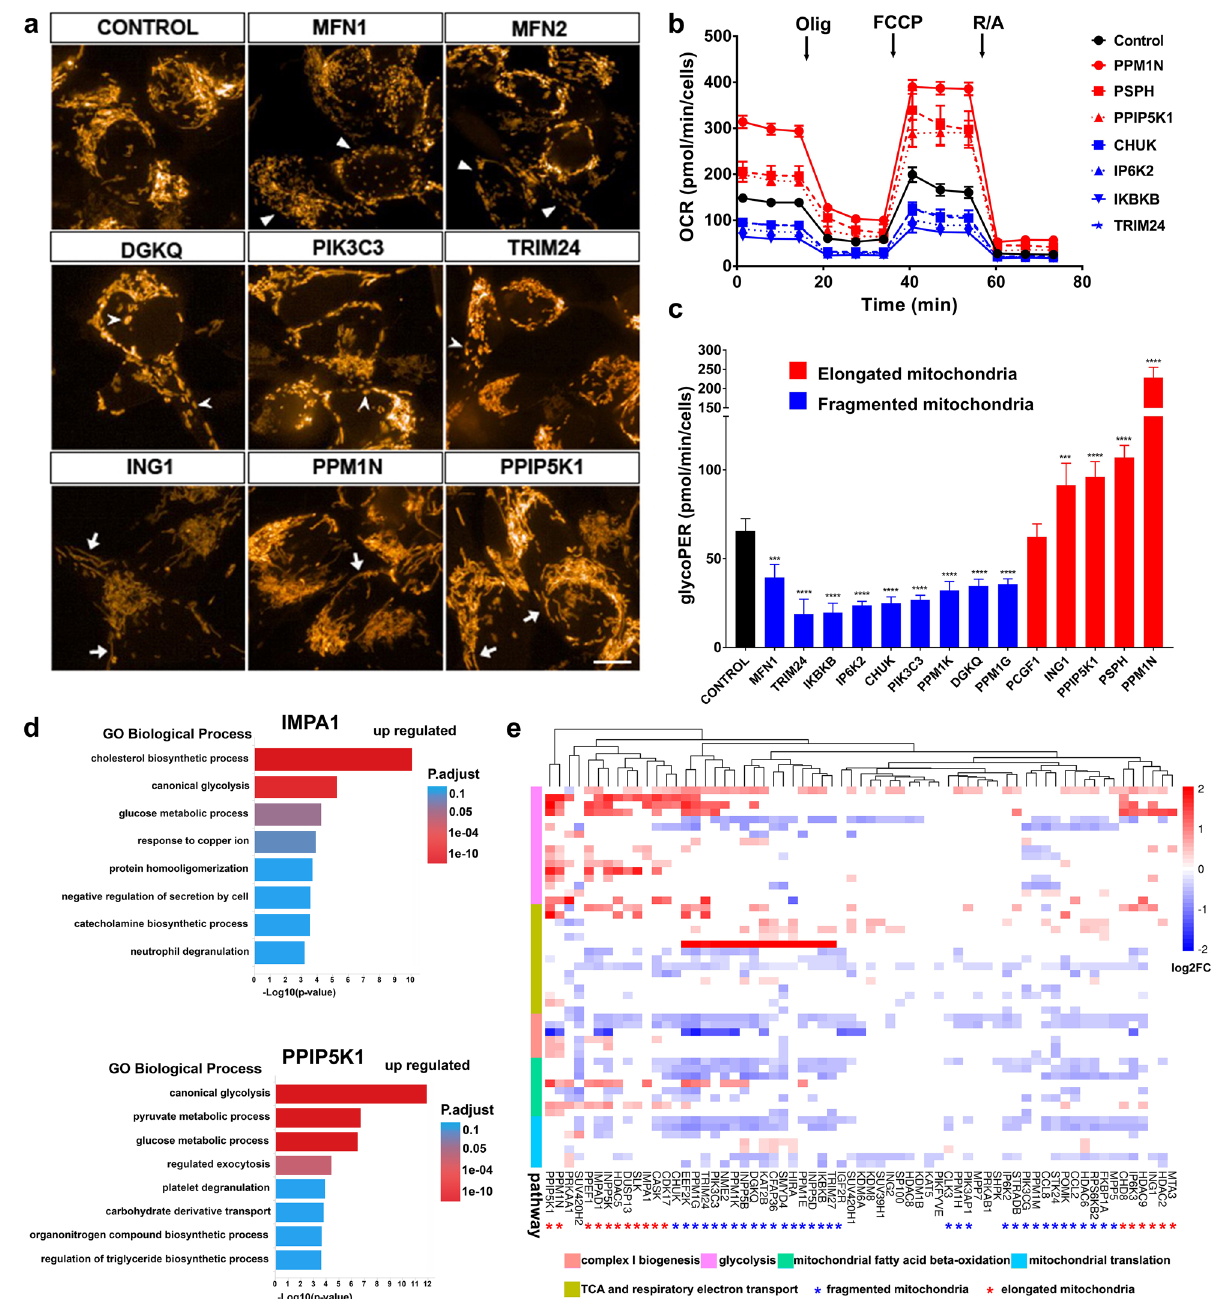
Figure 5. Mitochondrial morphology is correlated with cellular respiration preference and transcription. ( a ) MitoTracker red labeling reveals differences in mitochondrial morphology upon various gene disruptions via CRISPR, broadly categorized as fragmented or elongated mitochondria. Scale bar = 5 μm. Arrowhead points to fragmented mitochondria, open arrows indicate swollen globules and arrows indicate elongated mitochondria. ( b ) Seahorse mito stress test shows markedly different mitochondrial respiration function indicated by cell number normalized OCR, which correlates with mitochondrial morphology, red indicates elongated mitochondria while blue indicates fragmented mitochondria. Olig: oligomycin; R/A: rotenone and antimycin A. ( c ) Seahorse glycolytic rate assay indicates elongated mitochondria is associated with significant upregulation of glycolysis while fragmented mitochondria decreased glycolytic rate based on cell number normalized glycoPER. Error bars indicate standard deviation, n = 6, one-way ANOVA, F (14,60) = 172.8, p < 0.0001. Dunnett’s multiple comparisons, *** p -value < 0.001, **** p -value < 0.0001. ( d ) Enrichment analysis of RNA-seq DEGs of cells with elongated mitochondria reveals canonical glycolysis to be the top regulated biological process. ( e ) Hierarchical clustering heatmap of log2 fold change of DEGs involved in mitochondria related processes. Elongated mitochondrial morphology is strongly associated with upregulation of glycolysis genes while fragmented mitochondria have downregulation of genes in involved in TCA, complex I biogenesis and other critical mitochondrial